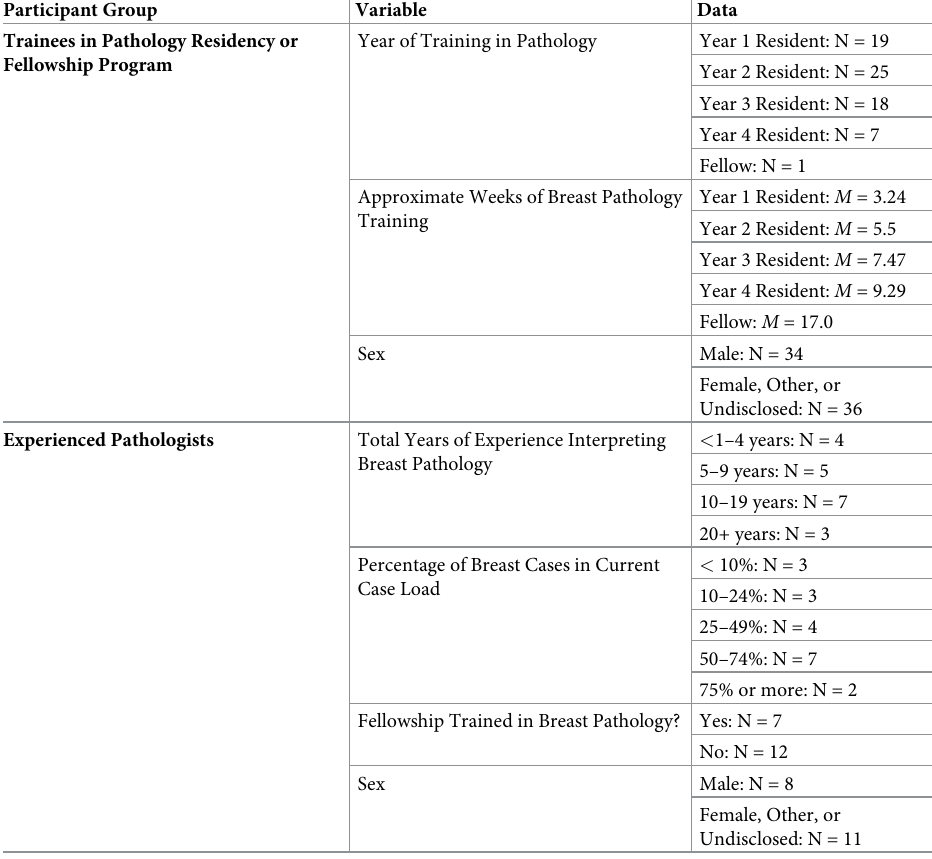
Table 2. Demographic